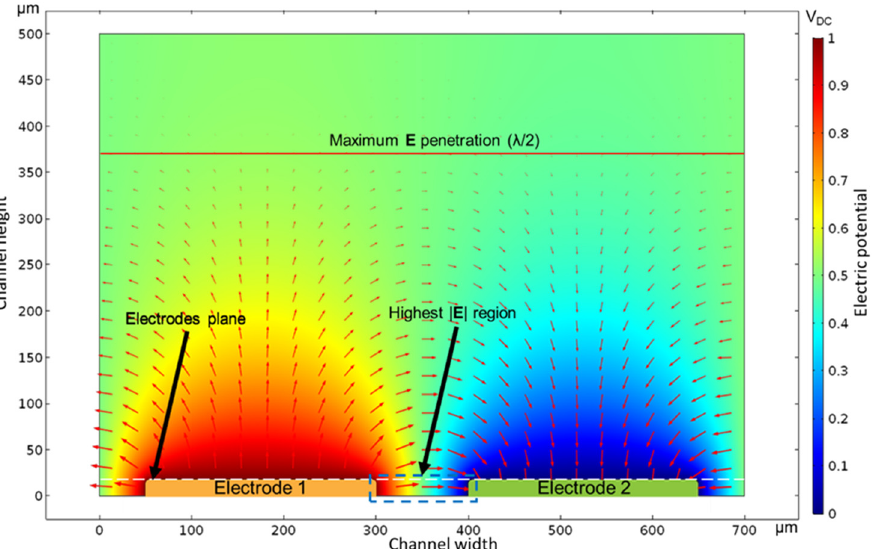
Figure 10. Electric potential and electric field distribution of a XY plane cut from the 3D model from the finite element analysis. Color gradients correspond to the potential electric distribution across the testing liquid. A potential differential of 1 VDC is applied to Electrode 1 with respect to Electrode 2. Arrows represent the electric field distribution, E = −∇ V .